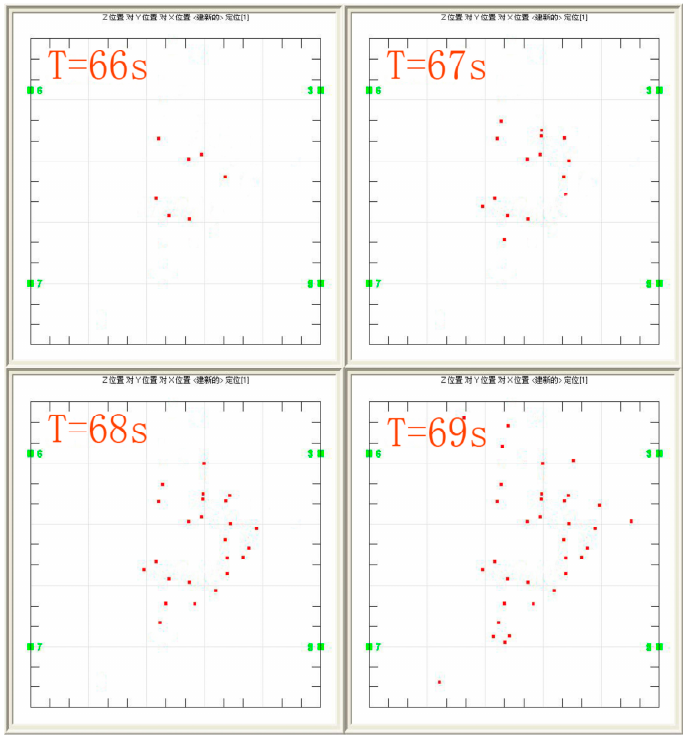
Figure 13. Top views of acoustic emission events in the No. 3 specimen at 66 s, 67 s, 68 s and 69 s.